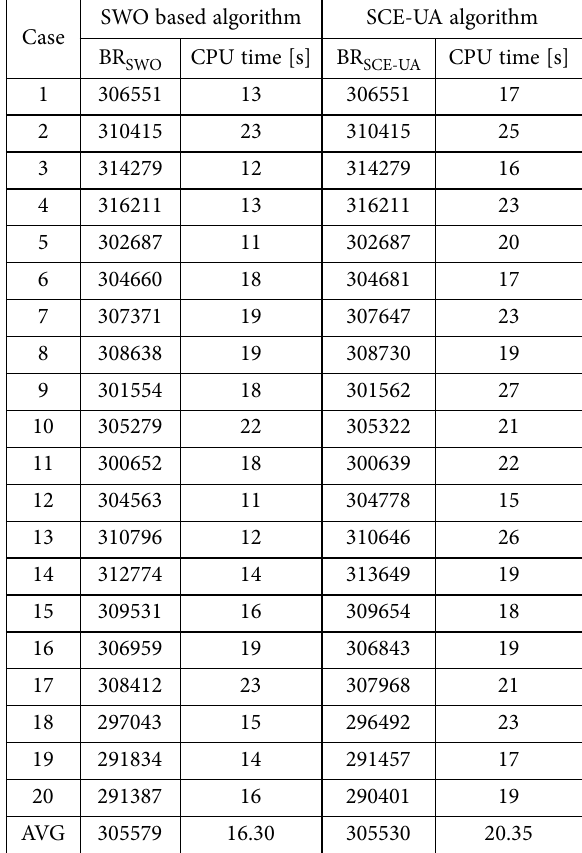
Table 4. Performance of BR SCE-UA in benchmark